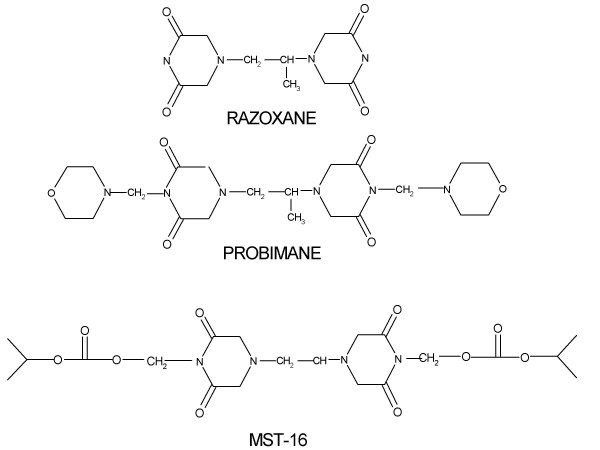
Structural formulae of three bisdioxopiperazines